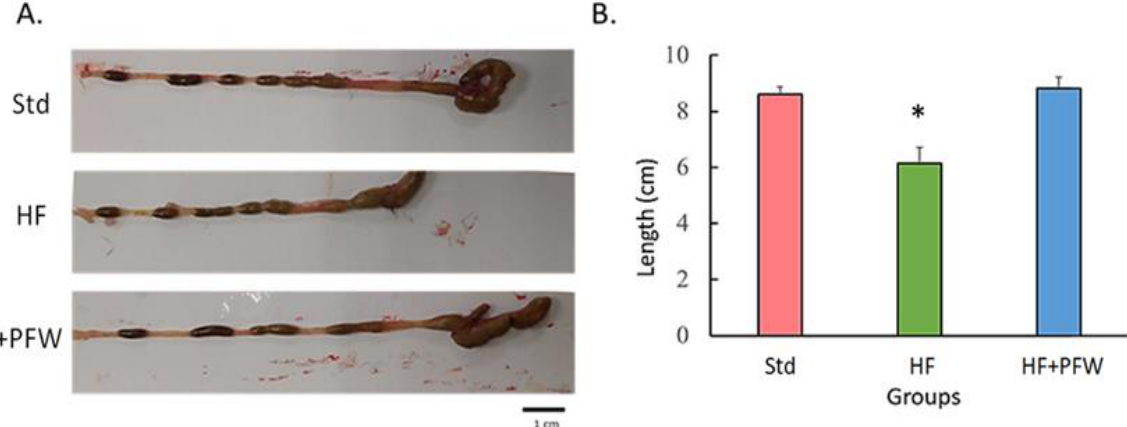
Figure 3. Effect of the PFW on colon length of mice. After 12 weeks of high-fat diet induction, the colon tissue of mice was collected and the length calculated. ( A ) Representative images (scale bar, 1 cm). ( B ) Quantified the length of the colon. Data were expressed as mean ± SEM. * p < 0.05 compared with the Std group. Group Std, standard diet; group HF, high-fat diet; group HF+PFW, high-fat diet plus PFW treatment.